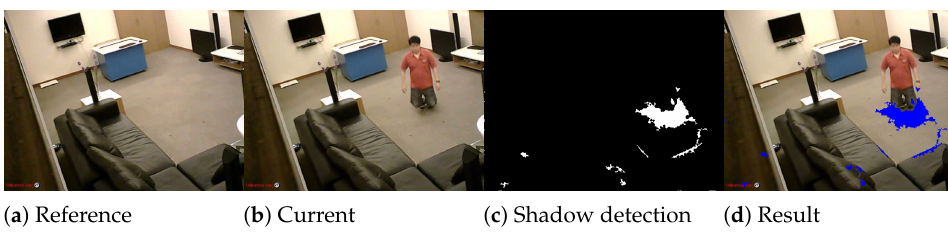
Figure 3. Illustration of Shadow detection. ( a ) The reference frame. ( b ) The current frame. ( c ) Shows the detected shadow pixels in current frame. ( d ) the result of shadow detection showed with blue color in current